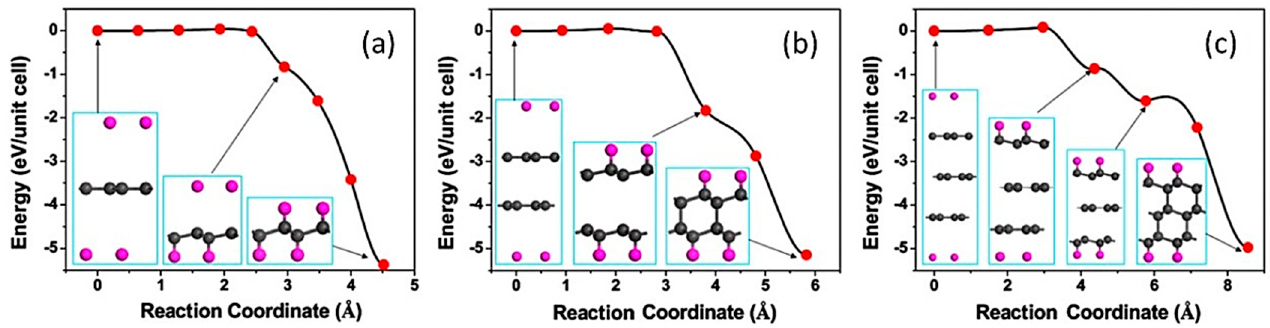
Figure 7. Model of few-layered graphene (FLG) hydrogenation resulting in a thin diamond-like film with the results of energy barrier calculations: ( a – c ) are the hydrogenation of single-, double- and triple-layer graphene. The initial configuration is selected so that H atoms (violet balls) are above or below planar FLG [34].